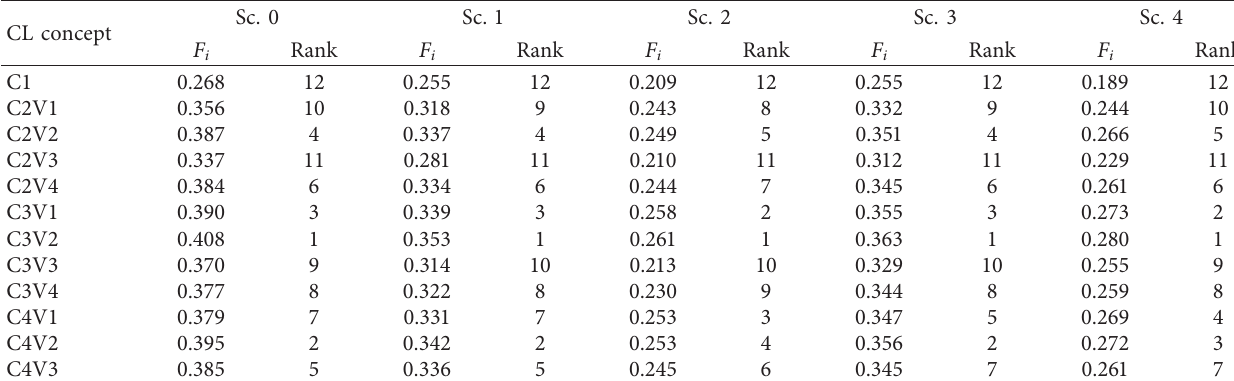
Table 7: Drone-based CL concepts ranking in sensitivity analysis